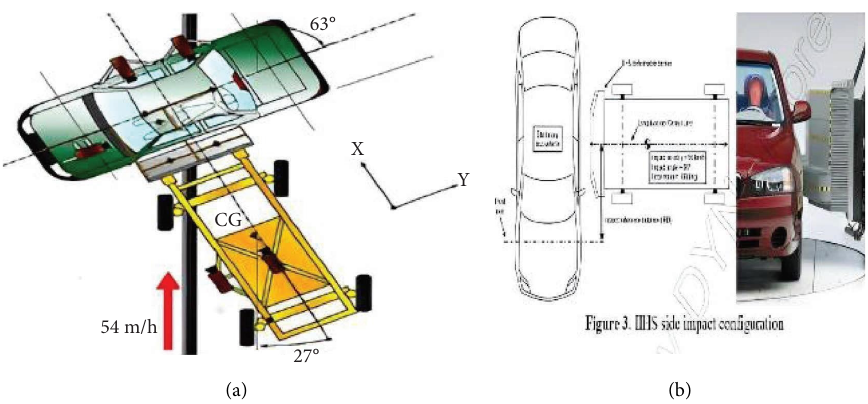
Figure 2: (a) FMVSS side impact test (b) IIHS side-impact